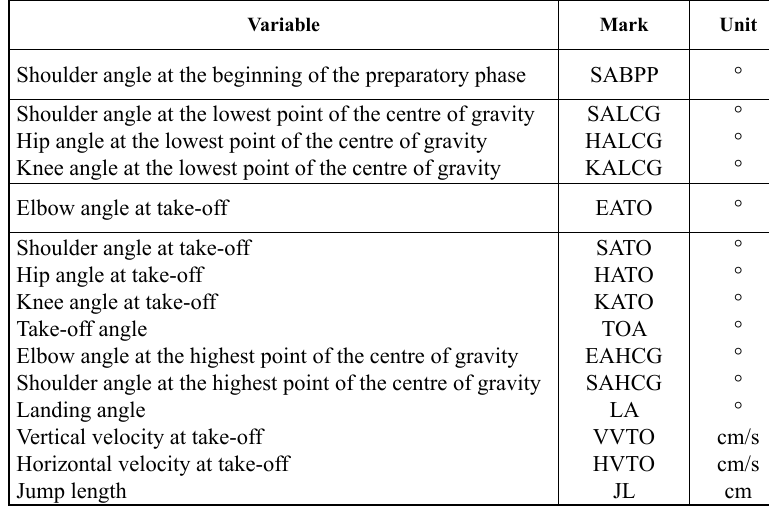
Table 2. Kinematic parameters determi- ning the standing long